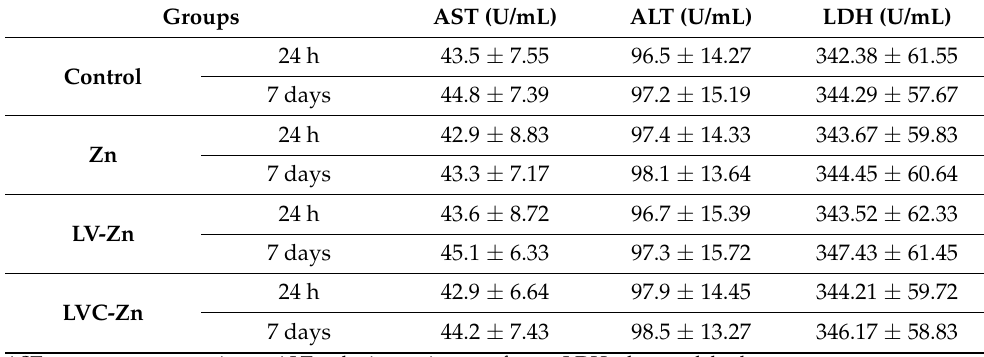
Table 2. The influence of LV-Zn and LVC-Zn on the AST, ALT, and LDH activity. Values were expressed as mean ± S.D. of mean for 6 animals in a group.